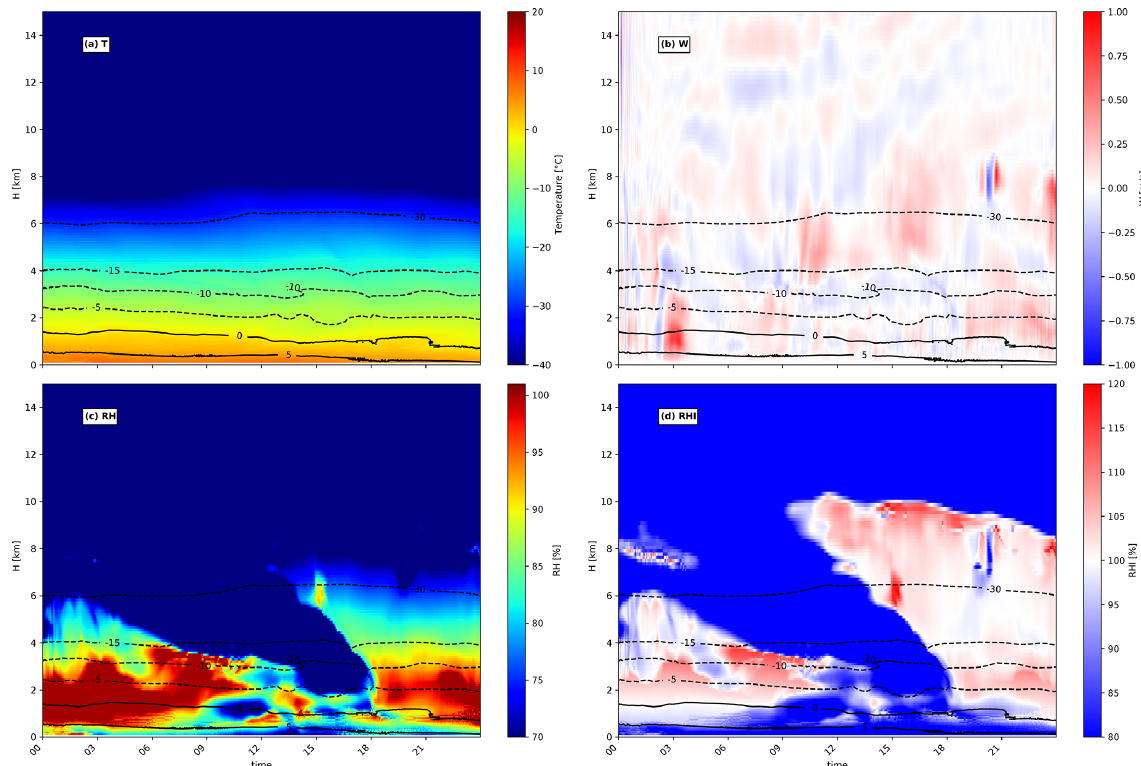
Figure B6. Temperature (a) , vertical velocity (b) , and relative humidity with respect to water (c) and ice (d) over Jülich in the SB06 default simulation on 3 January 2016. Temperature isolines are shown in each